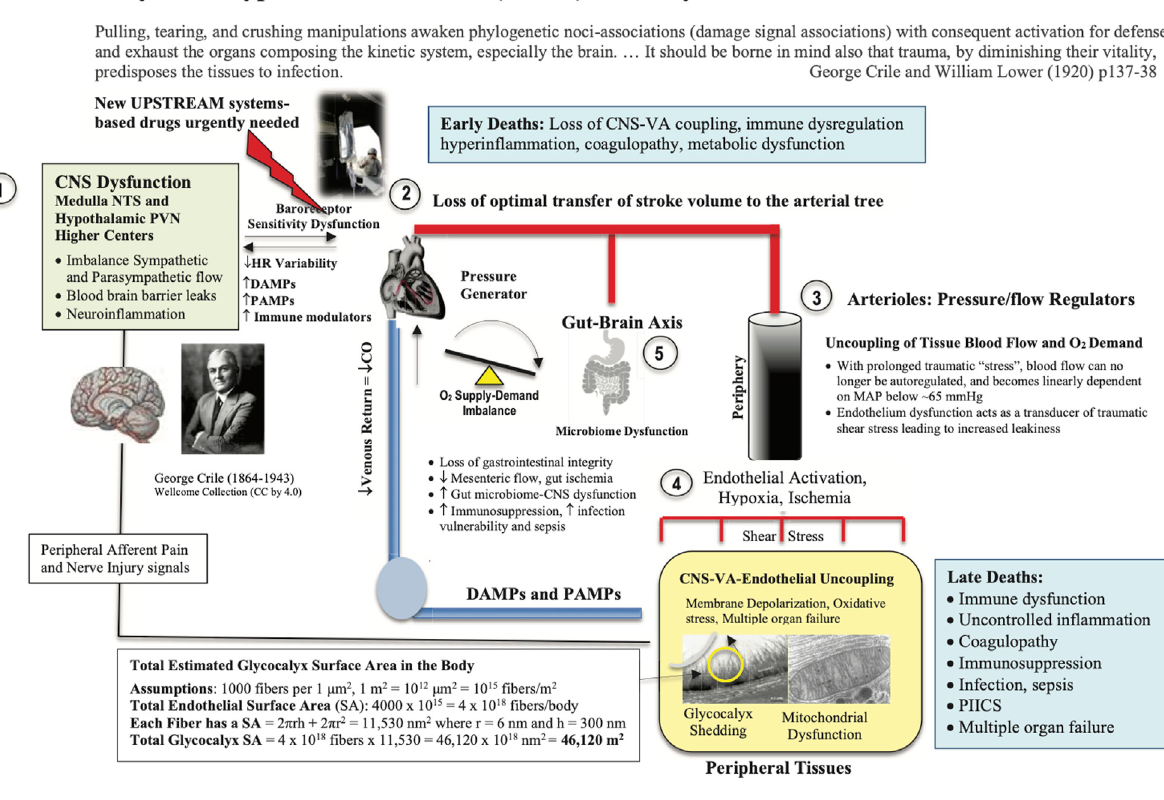
FIGURE 3 Systems Hypothesis Of Trauma (SHOT) showing key sites of uncoupling involving the: 1) brain, 2) heart, 3) vasculature, 4) endothelial- glycocalyx-mitochondrial functional unit, and 5) gut. Our hypothesis is that if central and local control of cardiac output and ventriculo-arterial (VA) coupling are improved, shear stress will be minimized, blood fl ow will be optimized, endothelial and microvascular function will be improved, and tissue O 2 delivery will be maintained. The injury phenotype is driven by sympathetic discharge, an increase in stress hormone levels, immune dysregulation and in fl ammation along with loss of baroreceptor sensitivity and reduced heart rate variability (Dunser and Hasibeder, 2009; Huston and Tracey, 2011; Matteoli and Boeckxstaens, 2013). Loss of normal central control may be attributed to the disruption to the BBB. New drugs are required toprotectthebrainand support VAcoupling to maintaintissue oxygenation (Dobson, 2014).Detailson theSAoftheendothelialglycocalyx can be found in Dobson et al., (Dobson et al., 2022b). BBB, blood brain barrier; ATP, adenosine triphosphate; CNS, central nervous system; CO, cardiac output; Cytaa 3 , cytochrome aa3; HIF-1, hypoxia inducible factor 1; HR, heart rate; MAP, mean arterial pressure; NF κ B, nuclear factor